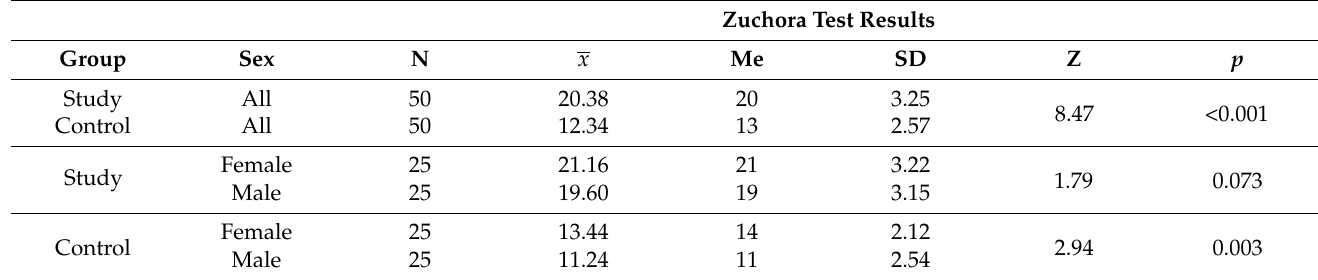
Table 4. Comparative analysis of the results obtained in the Zuchora test in both groups. Zuchora Test Results